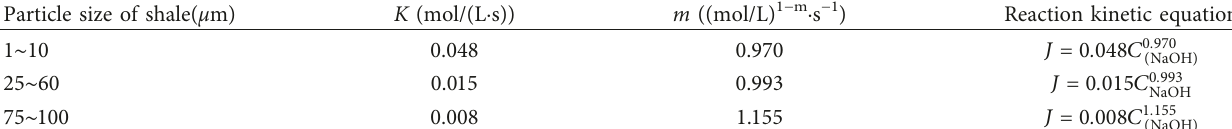
Table 4: Reaction kinetics equation of shale with different particle sizes.